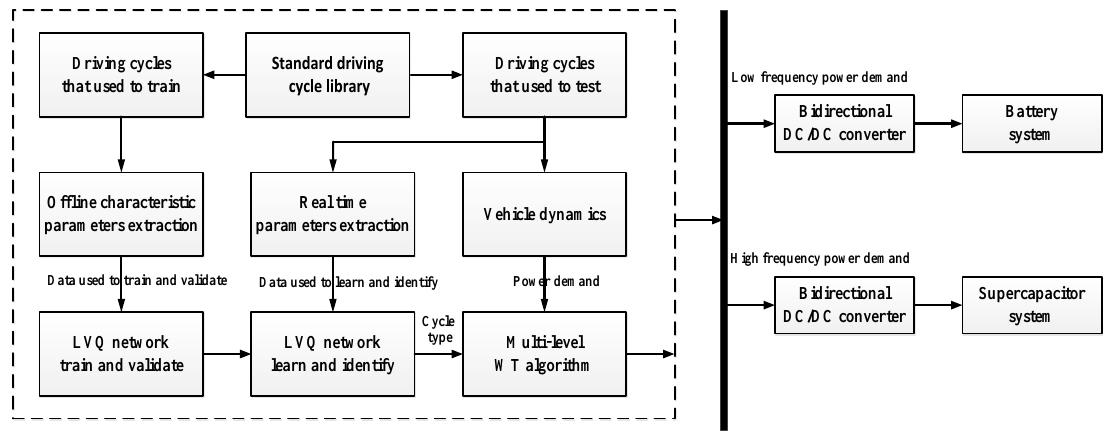
Figure 21. Frame of the proposed energy management system. DC, direct current; LVQ, learning vector quantization.